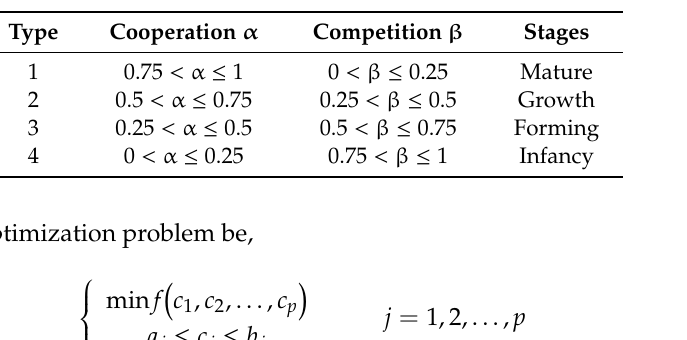
Table 3. The synergetic evolution period of urban-rural complex